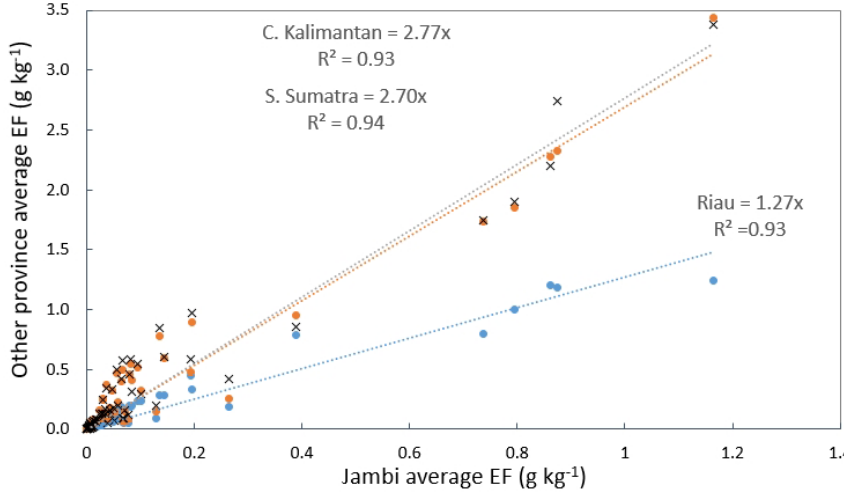
Figure 3. NMOG EFs calculated from WAS measurements in 2019 plotted for three provinces versus Jambi province, which had the lowest EFs on average. Riau (blue) EFs are about 27% larger than Jambi in this framework, and Central Kalimantan (gray) and South Sumatra (orange) EFs are about 2.7 times